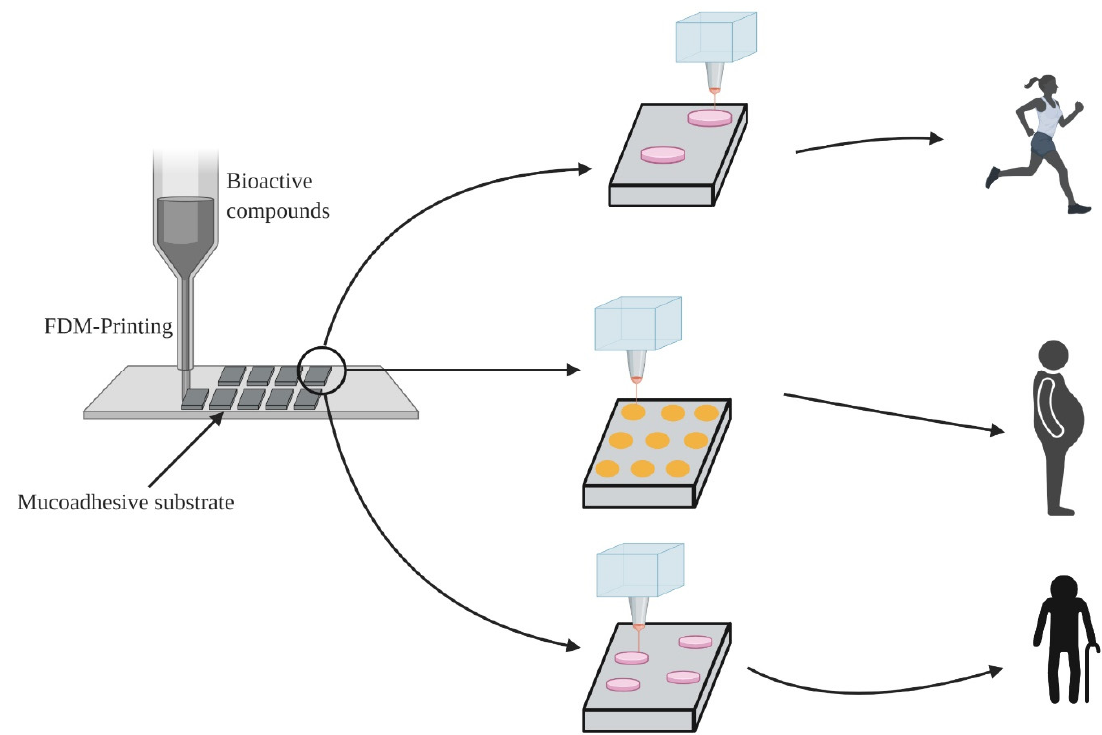
Figure 7. Personalized formulation of nutraceuticals for individuals using fused deposition models (created with Biorender.com).